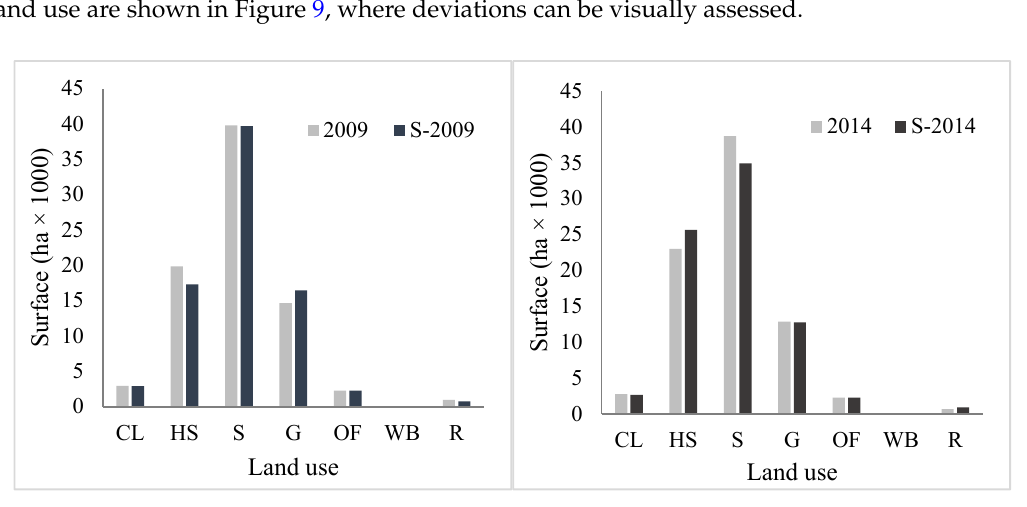
Table 7. Agreement between the real and simulated values of seven land uses of 2009 and 2014 in the urban and peripheral areas of Chihuahua